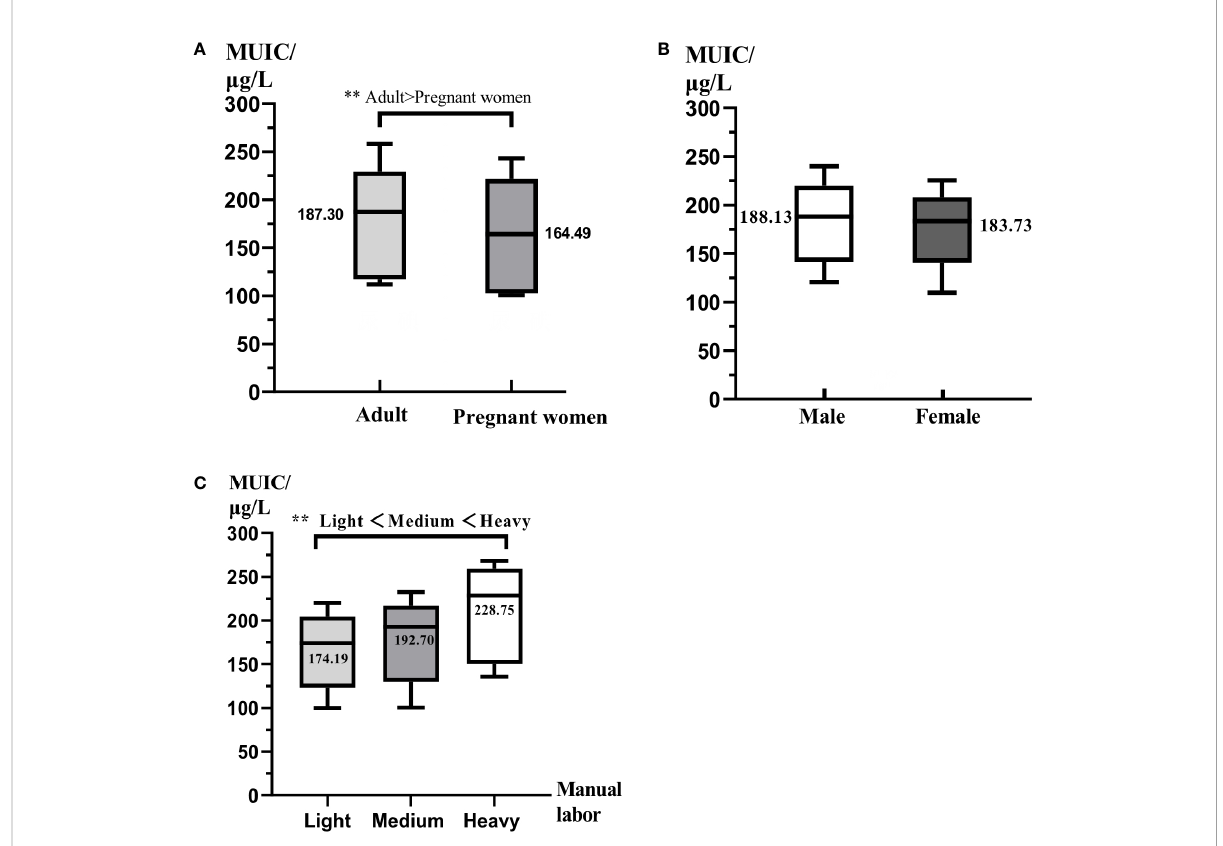
FIGURE 1 The comparison of iodine nutrition for different populations. All data were presented as median and interquartile range. MUIC was median urinary iodine concentration. (A) The comparison of iodine nutrition between adults and pregnant women. (B) The comparison of iodine nutrition between men and women. (C) The comparison of iodine nutrition of different labor intensity. ** represents P <